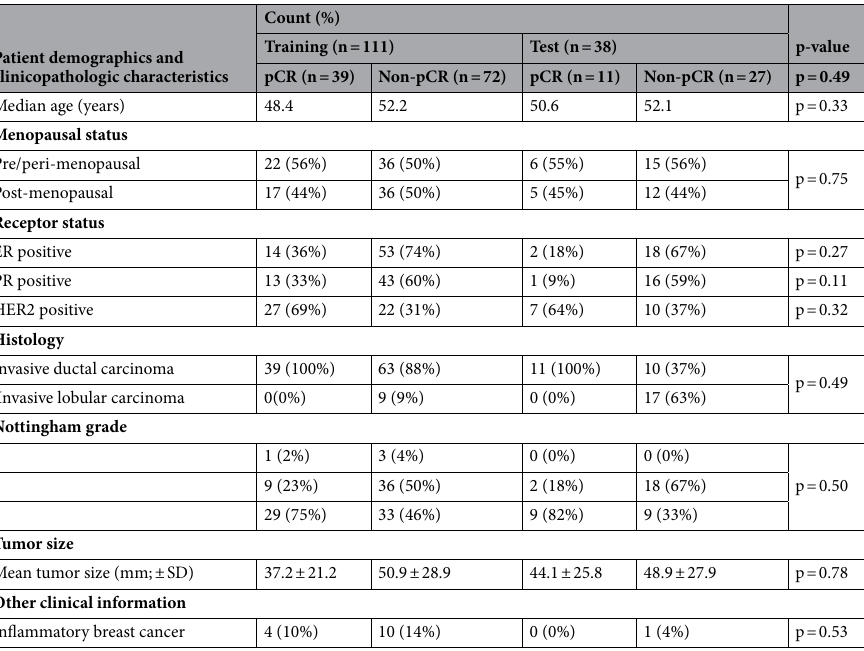
Table 1. Demographic and clinical information of the patients involved in the study. The distribution of each variable was compared between the training and test sets using the Pearson’s Chi-squared homogeneity test for categorical variables and the and t test for continuous variables; the p-values are reported in the last